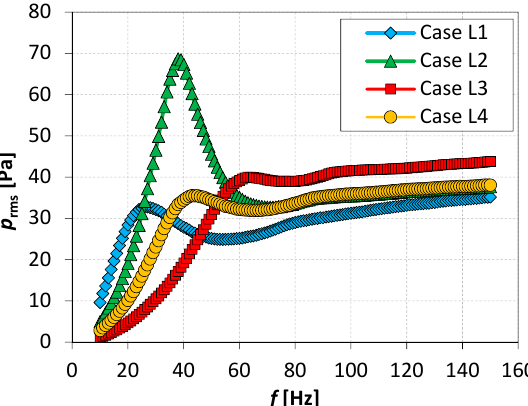
Figure 5. E ffective pressure in the SJA cavity as a function of frequency , P = 1.0 W. Figure 5. Effective pressure in the SJA cavity as a function of frequency, P = 1.0